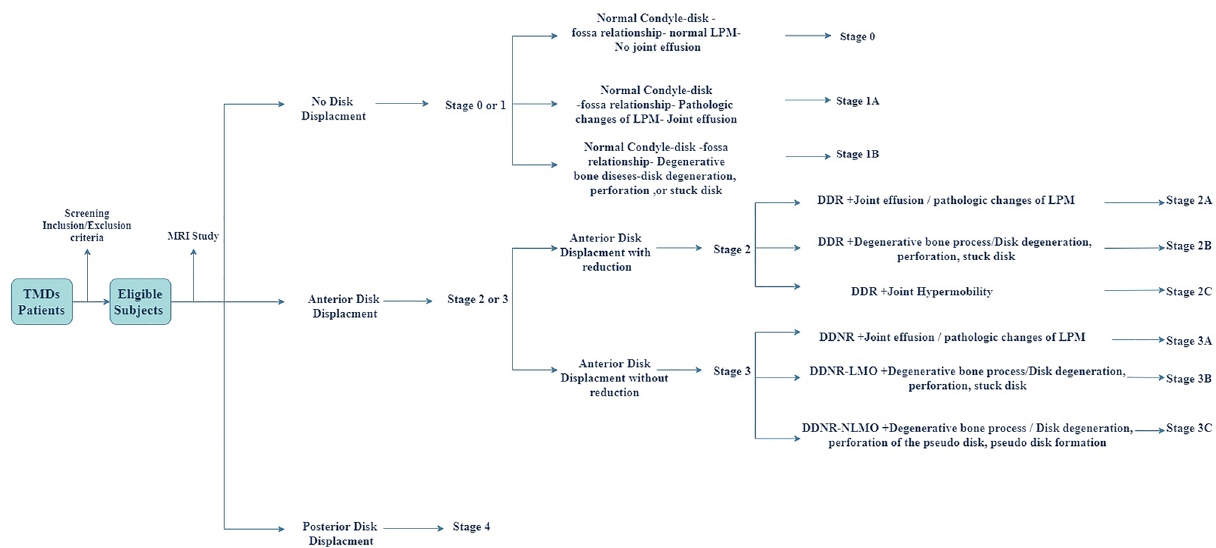
Figure 1. Flowchart represent the process of patients assignment into a